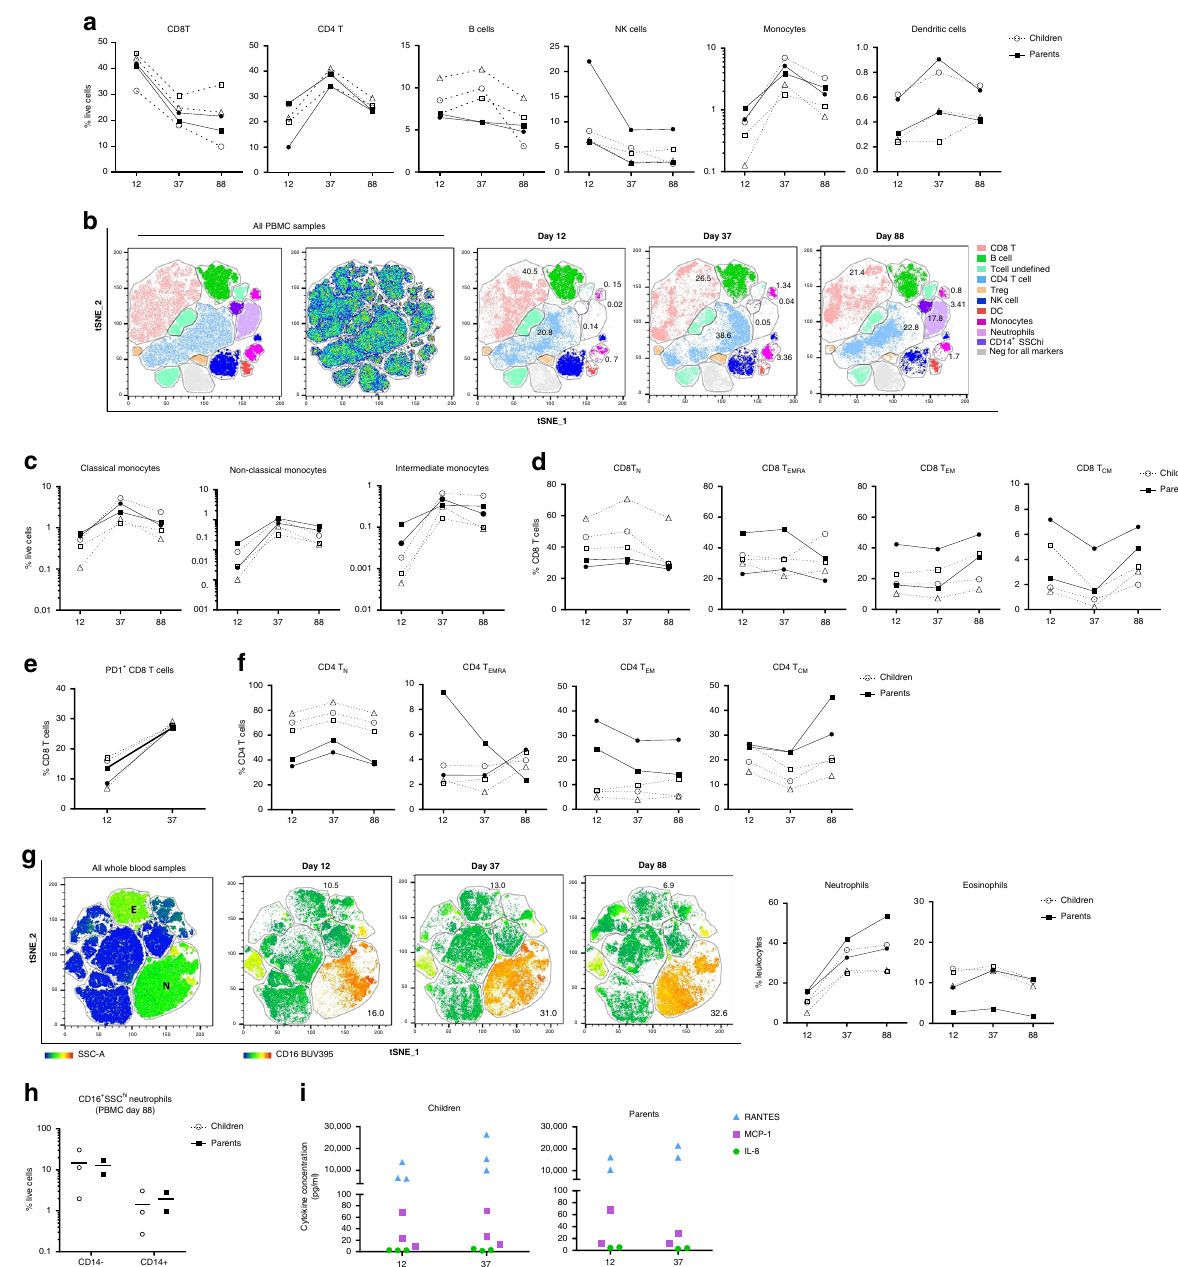
Fig. 2 Longitudinal cellular immune pro fi ling in parents and children. a Major immune cell populations in PBMC at day 12, 37, and 88 in parents (solid line) and children (broken line) (A1 (closed circles), A2 (closed squares), C1 (open circles), C2 (open squares), C3 (open triangles)). b tSNE dimensionality reduction of immune cell populations in all PBMC samples across the three-time points. The tSNE plot was generated from a concatenated fi le containing 300,000 events (20,000 randomly selected live single cells per patient per time point). c . Frequency of monocyte subpopulations in PBMC from parents and children. d Frequency of CD8 T cell naive, effector, and memory subpopulations in PBMC. e Frequency of PD1 expressing CD8 T cells over time. f Frequency of CD4 T cell naive, effector, and memory subpopulations in PBMC. g tSNE dimensionality reduction of whole blood samples. The tSNE plot was generated from a concatenated fi le containing 300,000 events (20,000 randomly selected live single cells per patient per time point). Coloring depicts SSC and CD16 expression in tSNE islands. Granulocyte populations (neutrophils and eosinophils) are expressed as the proportion of leukocytes. h Frequency of low-density CD16 + SSC hi neutrophils (CD14 + and CD14 − ) in PBMC fraction at day 88. i Plasma cytokine concentration of three detectable cytokines, RANTES (blue), MCP-1 (purple), and IL-8 (green) in children and parents at day 12 and